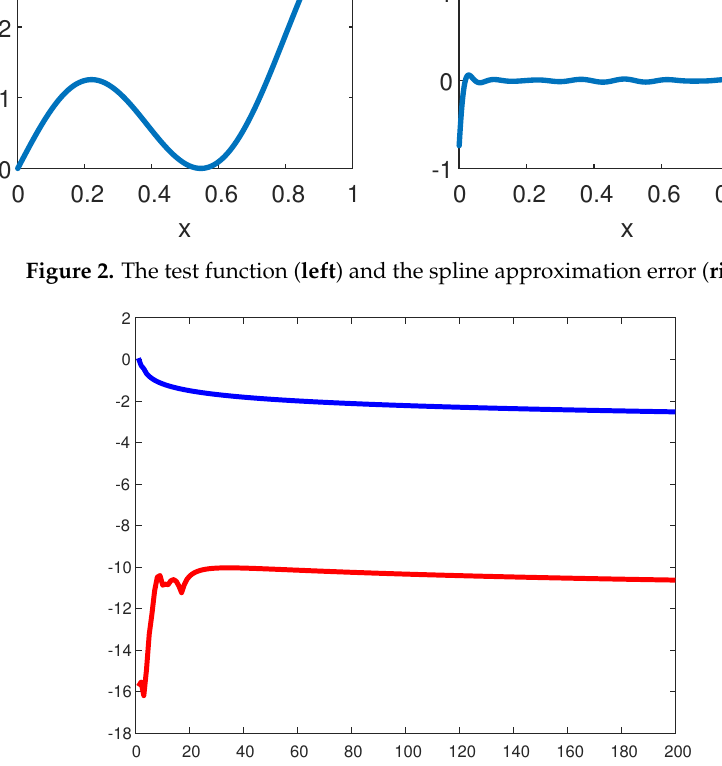
Figure 3. log of the given Fourier coefficients (blue), and of the Fourier coefficients of the 10 approximation error